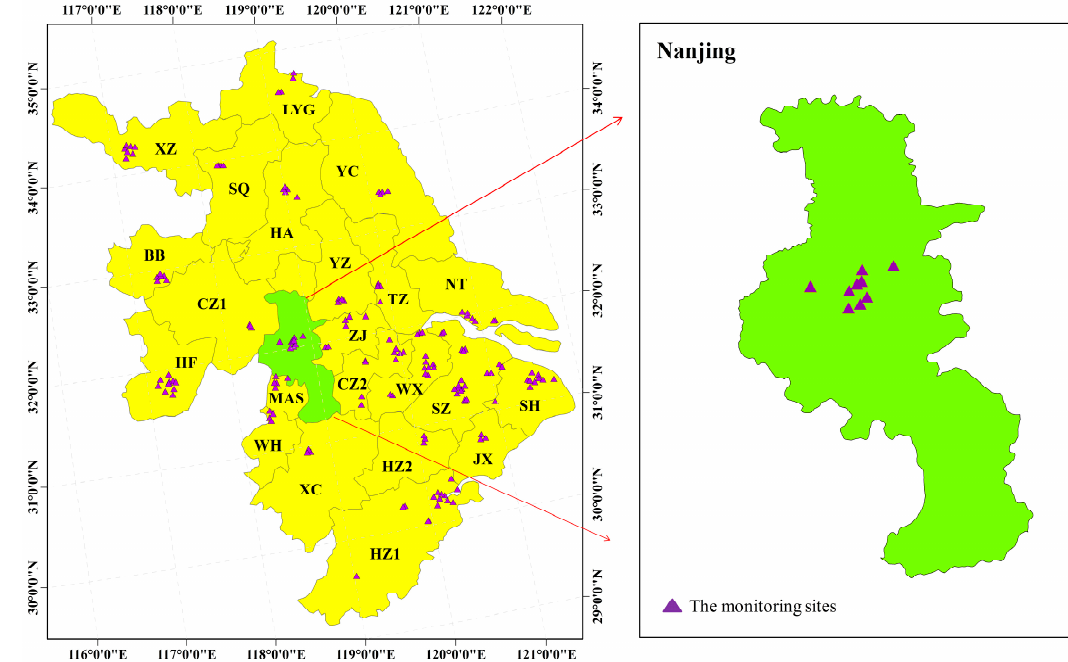
Figure 1. Distribution of air quality monitoring stations in Nanjing and surrounding cities.